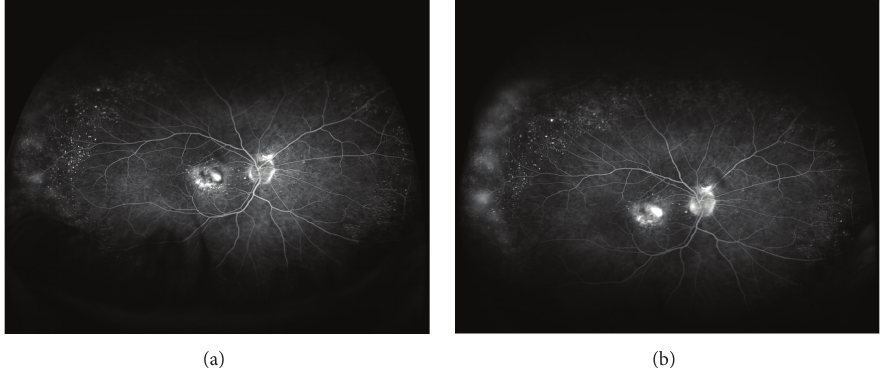
Figure 3: Wide-field fluorescein angiogram images at one (a) and five (b) minutes of the run showing vascular leakage in the temporal retinal periphery in an eye with minimally classic choroidal neovascularisation.